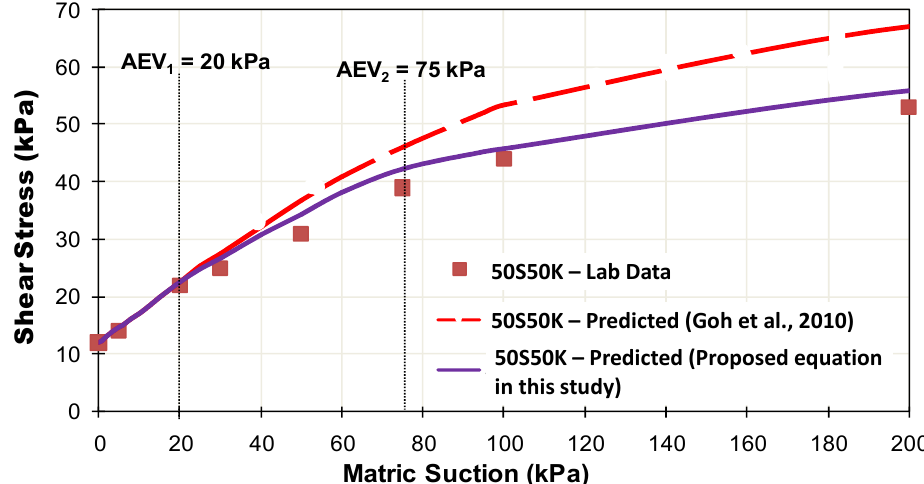
Figure 13. Goh et al. [44] and the proposed equation in this study for predicting shear strength of 50S50K. Table 4. Shear strength prediction parameters based on Goh et al. [44] Equation.